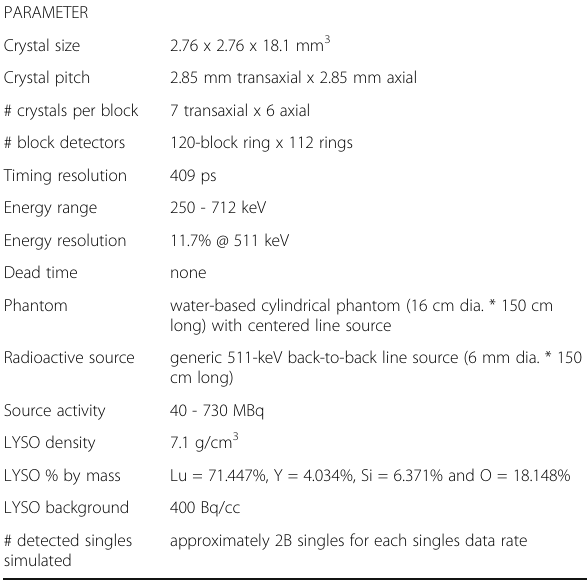
Table 1 (abstract A12). Simulation